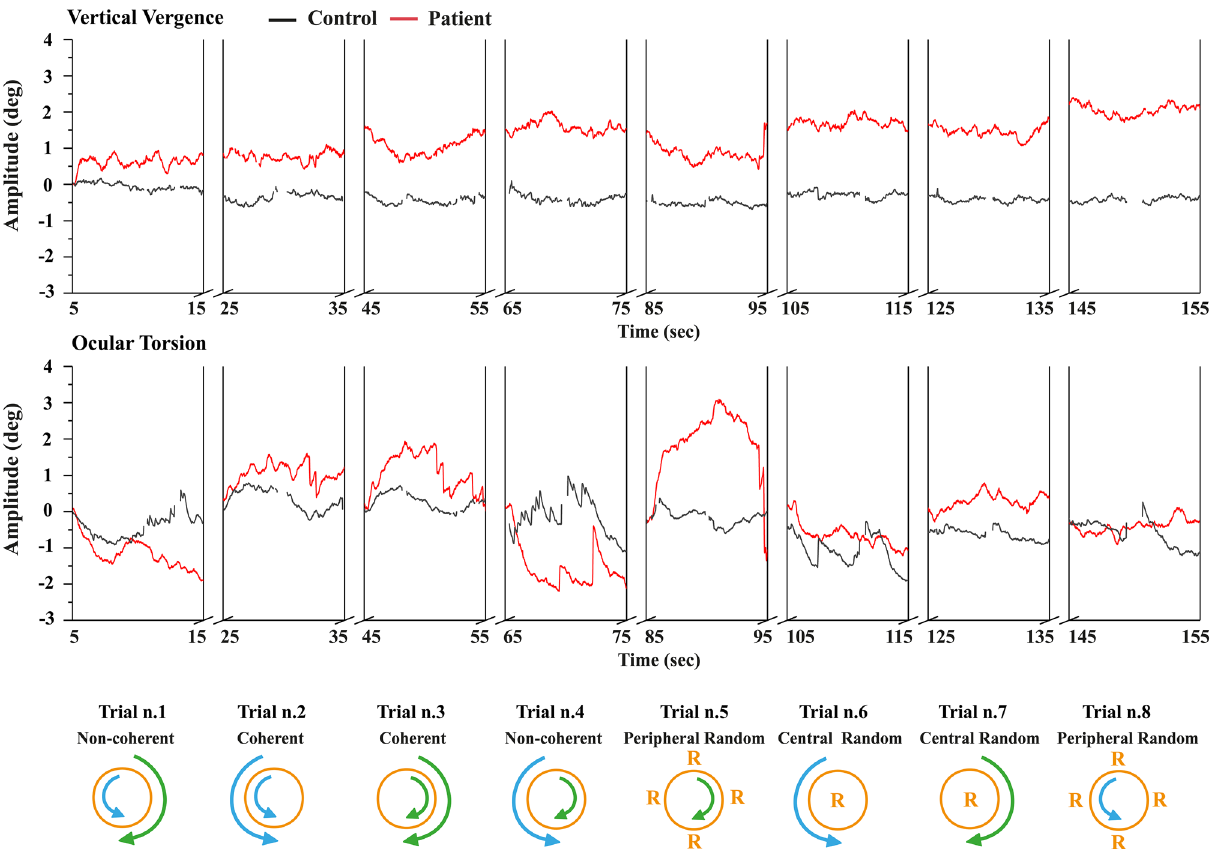
Figure 2. Stimulation pattern effect in patients and controls on ocular torsion and vertical vergence responses. Graphical illustration of the vertical vergence optokinetic response recording (above), and the ocular torsion response (below) between a healthy individual (Black) and a concussed patient with VID (Red). Baseline values, i.e. eye position at rest, has been removed from the figure for fitting purposes as indicated by breaks in the X-axis. Below is a graphical illustration of all stimulation patterns, numbered according to the order they were presented at during the session and corresponding with the eye movements outlined directly